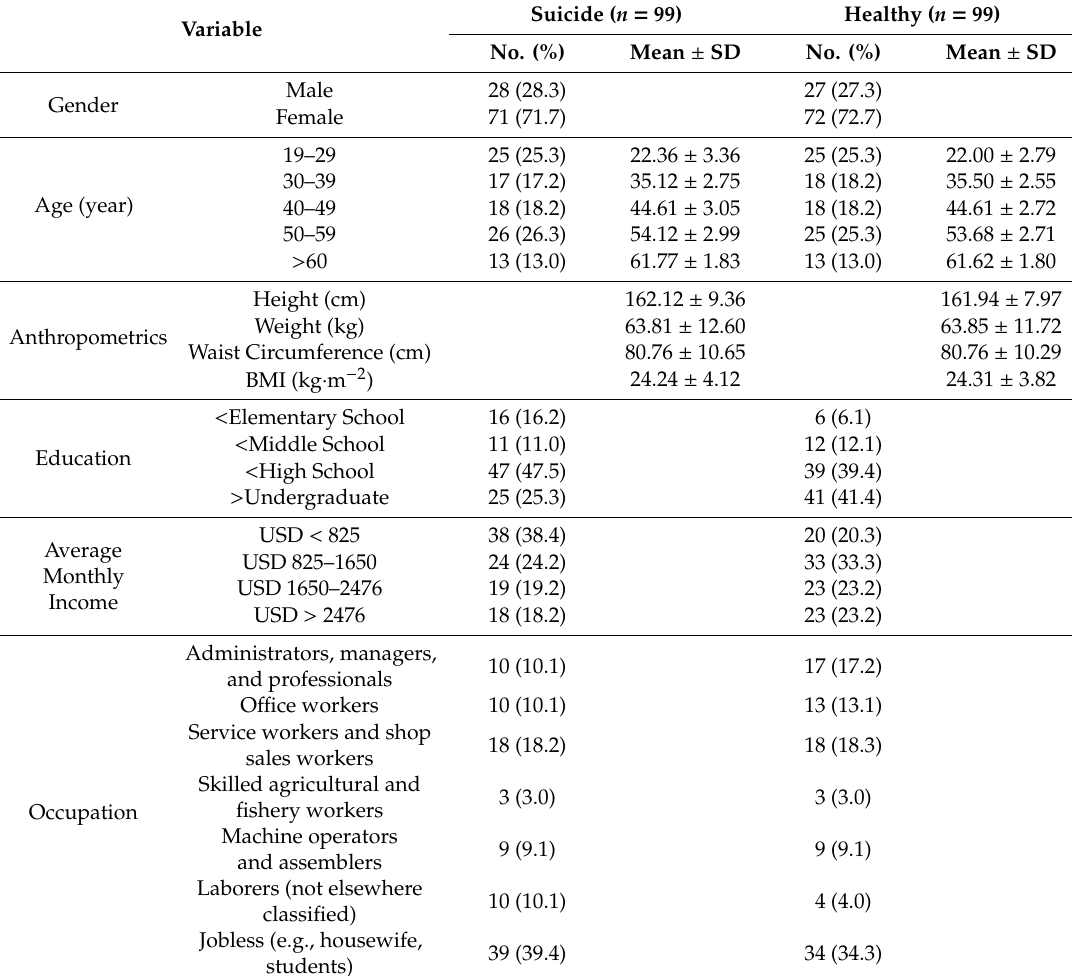
Table 1. Characteristics and body composition for participants in the suicide and healthy